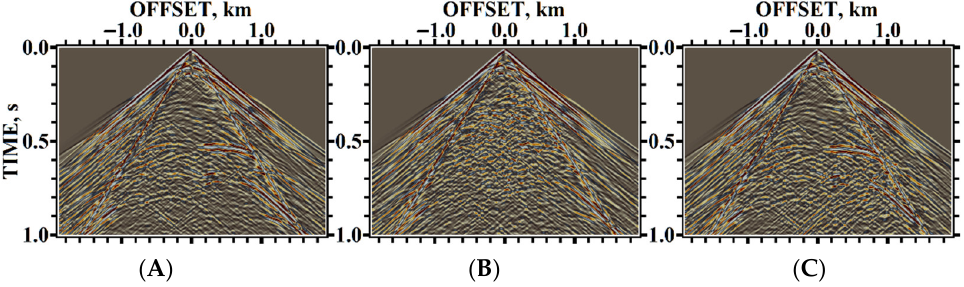
Figure 37. Example #5, seismograms, vertical component of velocity: ( A ) «without fractures»; ( B ) «fractured zone #1»; ( C ) «fractured zone #2».